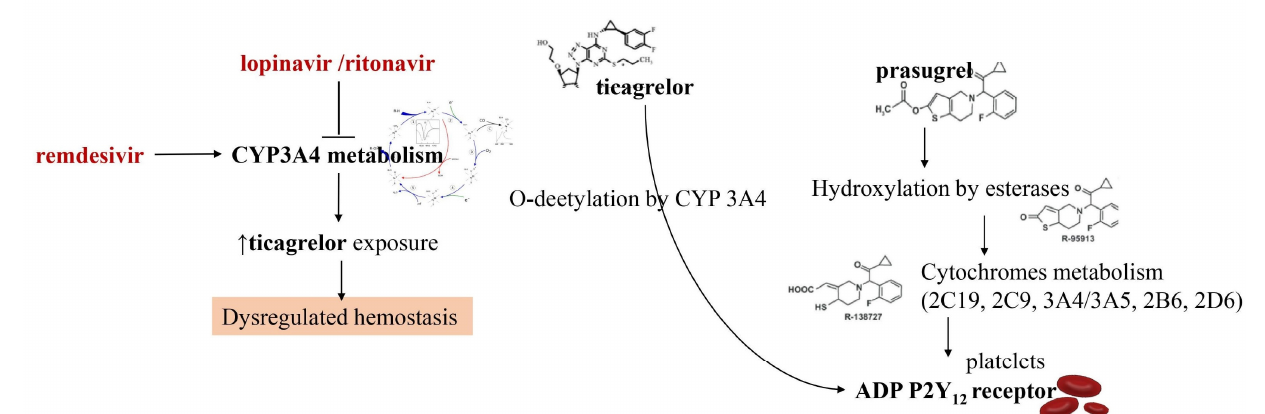
Figure 1. Interaction between antiviral agents and antiplatelet drugs on CYP3A4 metabolism. In red, antiviral agents are depicted. Lopinavir and ritonavir exert an inhibitory action on the cytochrome. This increases the exposure of ticagrelor leading to a dysregulation of hemostasis (highlighted in the picture being it the only depicted potential effect). Remdesivir is instead an inducer of CYP3A4 function. Differently from ticagrelor, prasugrel is metabolized by several cytochromes (2C19, 2C9, 3A4/3A5, 2B6, 2D6), thus its effects seem to be unmodified by ritonavir or lopinavir interaction. CYP3A4: Cytochrome P450 3A4, ADP P2Y12 receptor: adenosine 5 ′ diphosphate P2Y12 receptor.